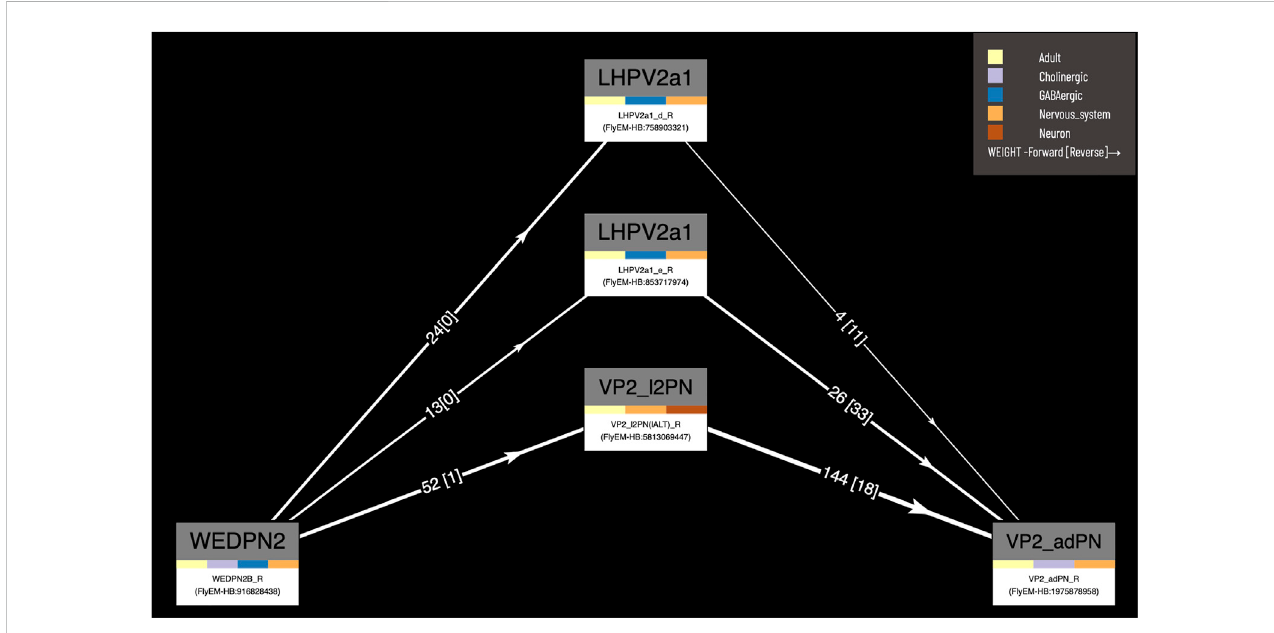
FIGURE 8 Circuit browser. A circuit diagram of paths between “ WEDPN2B_R ” and “ VP2_adPN_R ” . Rectanglesrepresent neurons with the symbols of classes at the top, names of individual neurons at the bottom and colors corresponding to gross classi fi cations in the middle. The legend for these gross classi fi cations can beseeninthetop-right[notetheWDPN2isclassedasbothcholinergicandglutamatergicbasedonantibodystainingevidence(Dolanetal.,2019)].Pathways are ordered from “ strongest ” at the bottom to “ weakest ” at the top. Arrows show the direction of synaptic connectivity and numbers outside of brackets show the number of synapses annotated for each connection. Numbers inside brackets show the number of synapses in the opposite